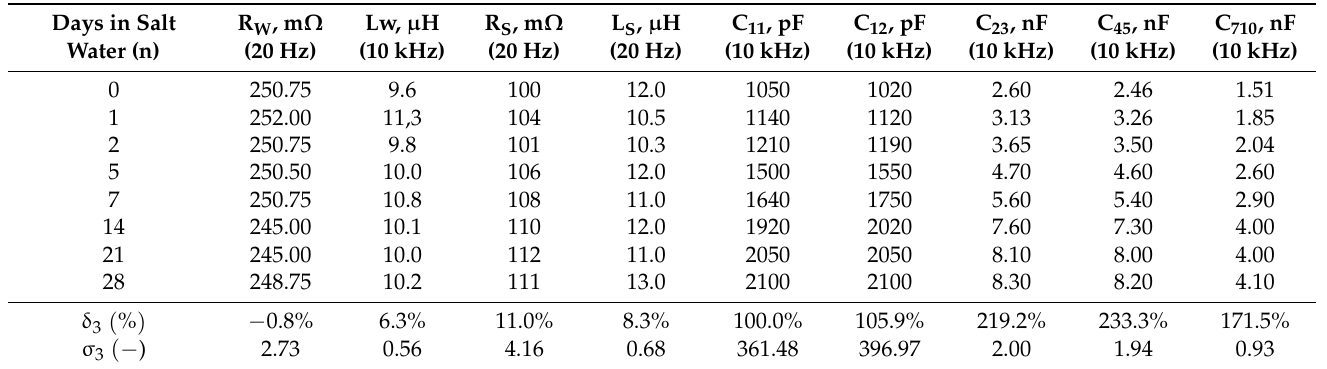
Table 4. Measurement results of CT3 (n = 0 stands for the nominal parameters of the